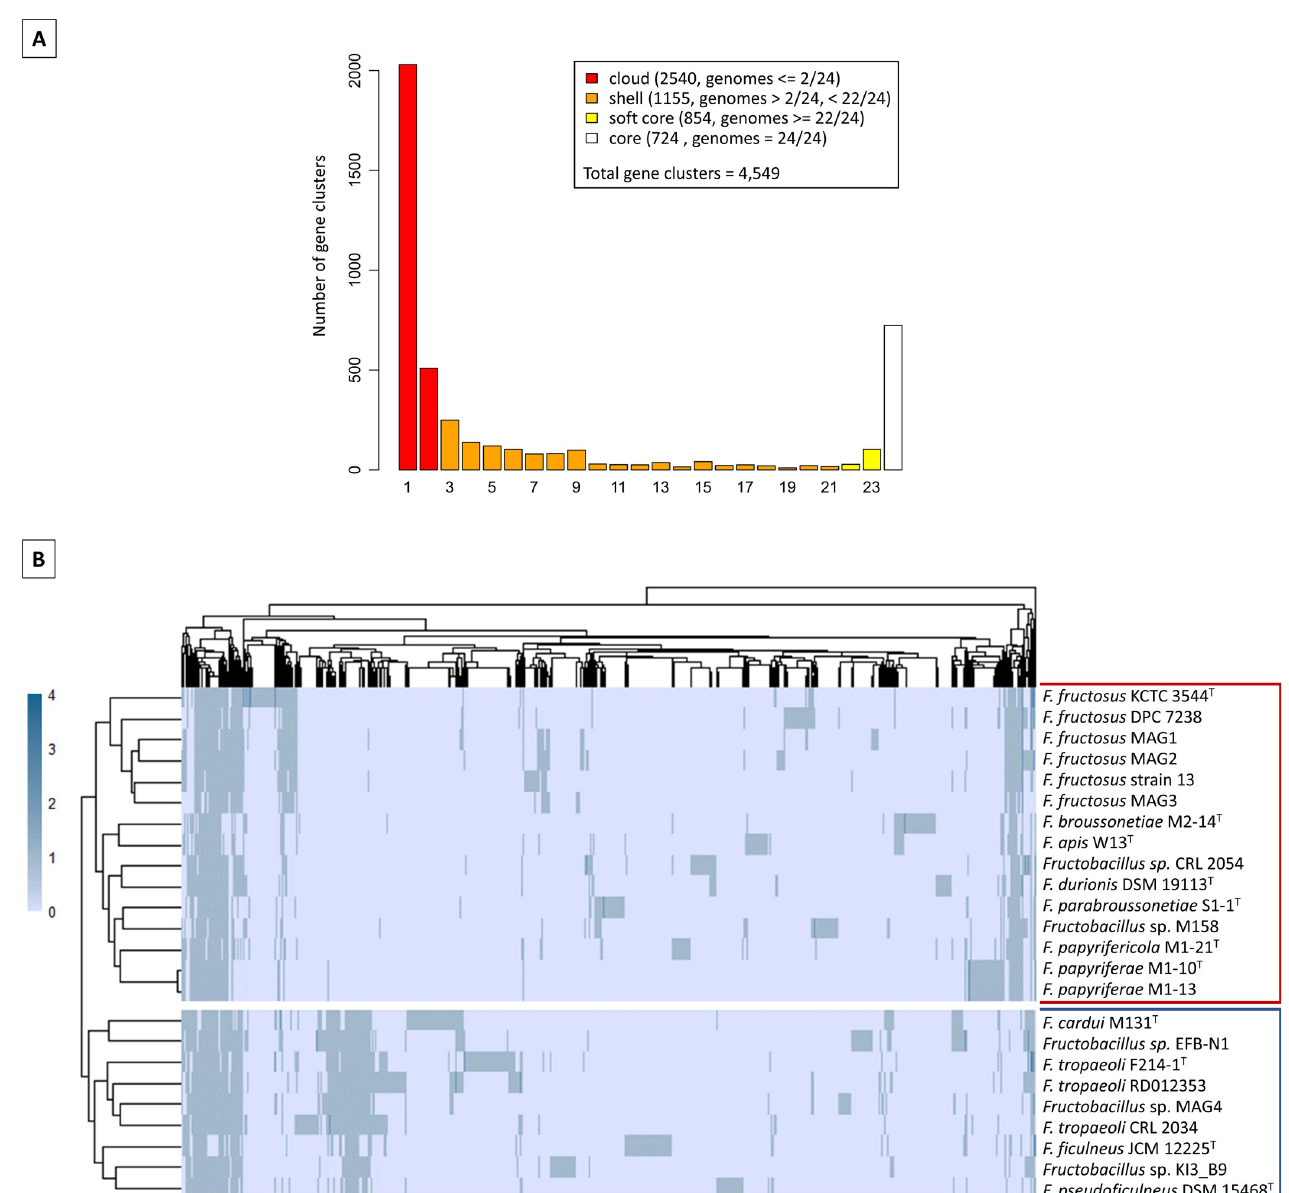
Fig 3. Pangenome analyses. A: Bar graph showing the number of gene clusters present in 1 to 24 Fructobacillus genomes. The color of the bars represents the cloud, shell, soft-core, or core genes. B: Clustered heatmap based on the presence (blue bars) or absence (light blue bars) of gene families in the dispensable genome of Fructobacillus strains. Organisms belonging to clades 1 or 2 of the phylogenetic analyses are enclosed with a red (clade 1) or blue (clade 2)